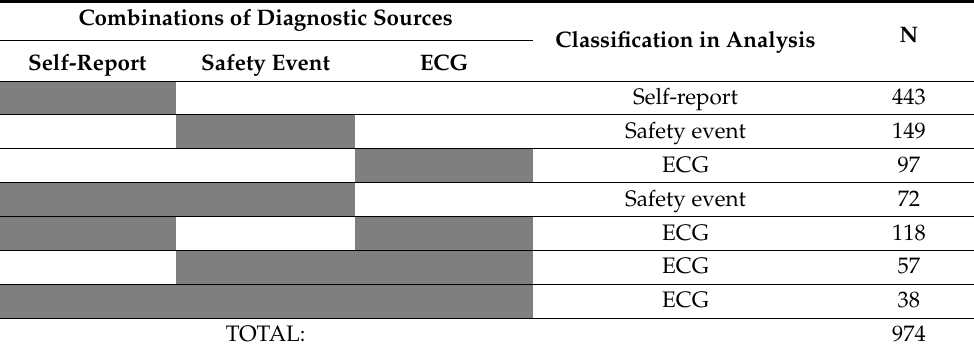
Table 2. Breakdown of atrial fibrillation diagnostic sources,